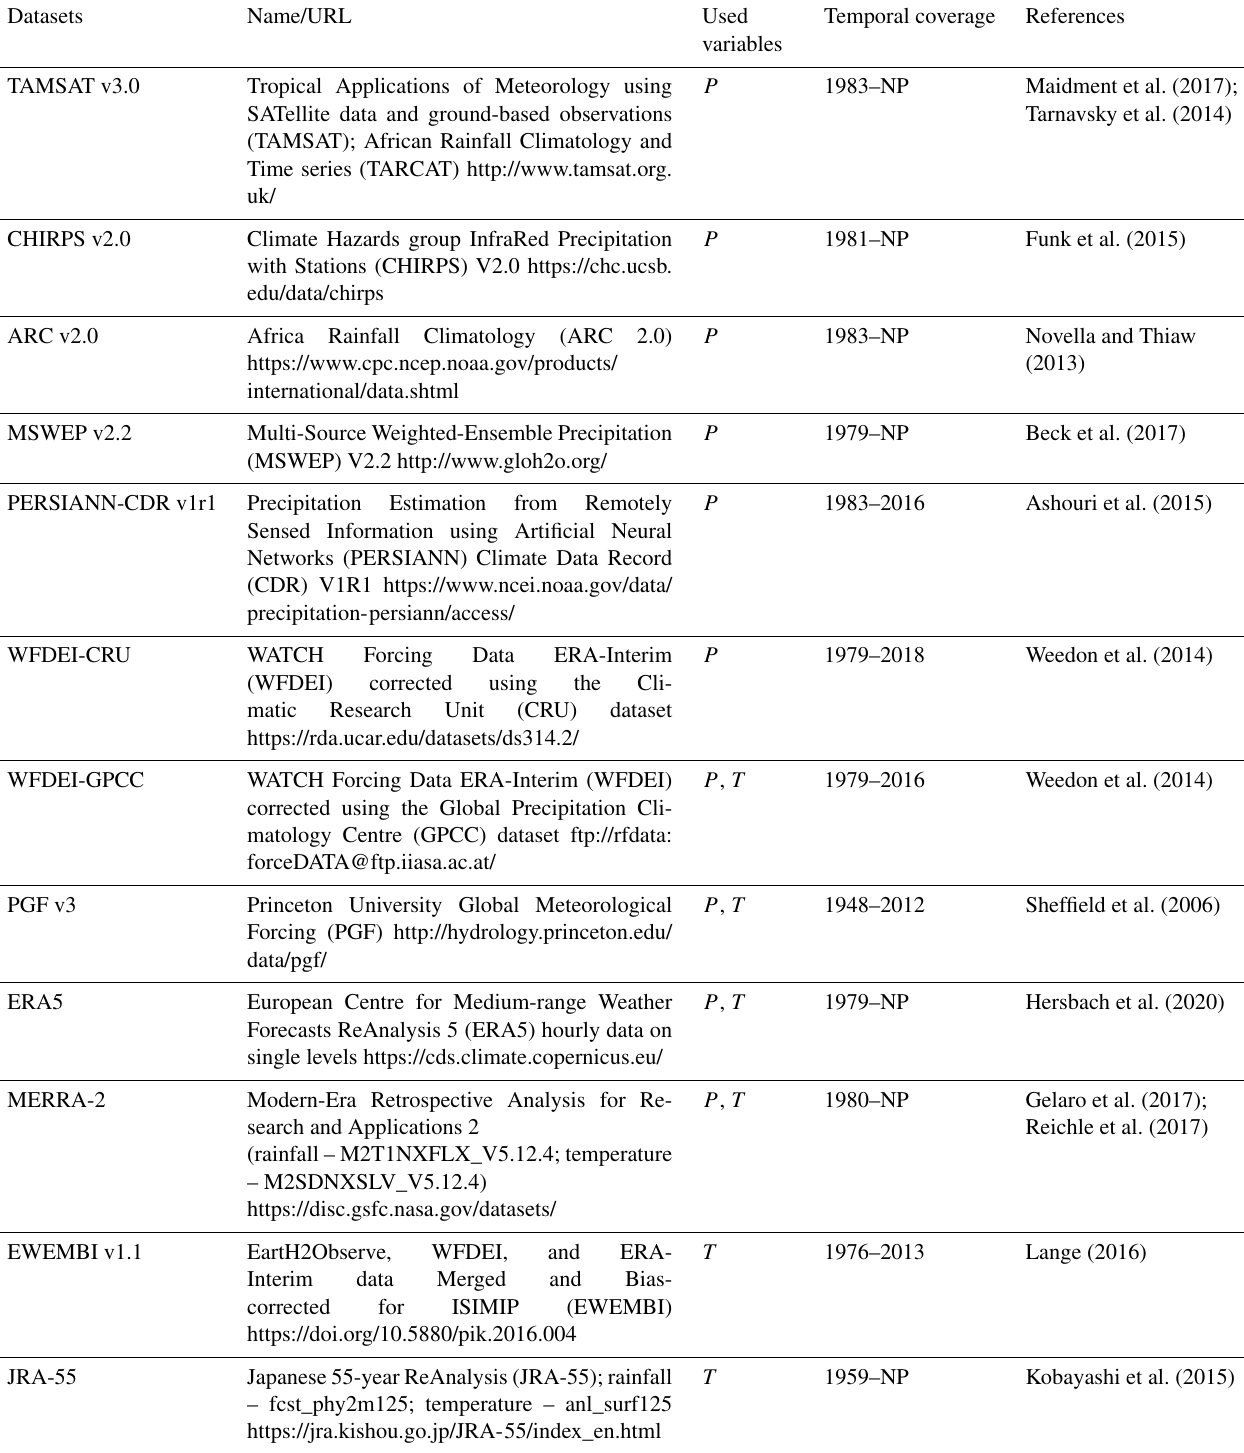
Table 2. Satellite- and reanalysis-based rainfall and temperature products for climate projection data evaluation. Note: P rainfall; T – temperature; NP – near